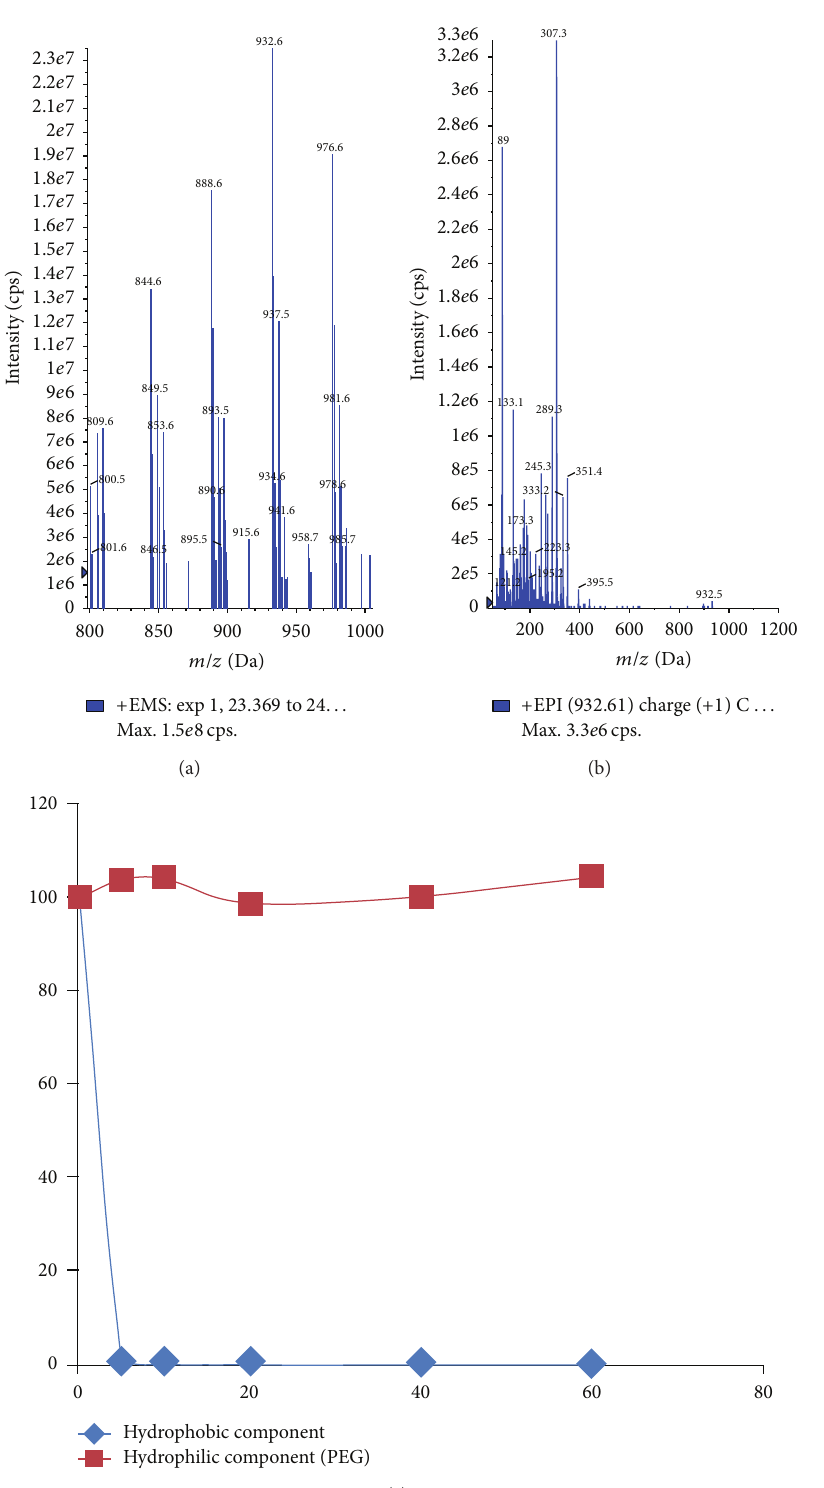
Figure 4: (a) Parent ion scan representing the molecular ions of hydrophobic oligomers (glycerol polyoxyethylene ricinoleate) of CrEL (b) Fragmentation pattern of selected oligomer with m/z 932.50. (c) Remaining percent versus time curve representing the plasma stability of hydrophilic and hydrophobic components of